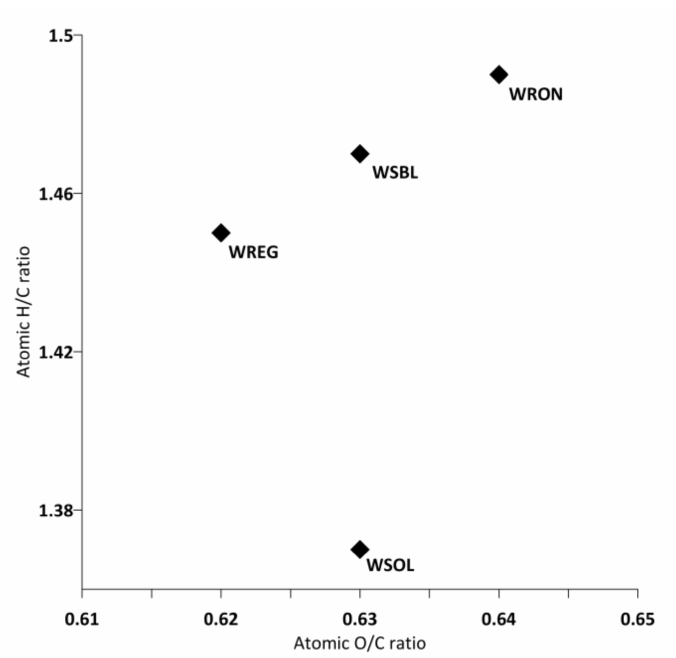
Figure 1. Molar ratio of hydrogen and oxygen (Van Krevelen Diagram): WSBL—Seyval Blanc, WSOL—Solaris, WREG—Regent and